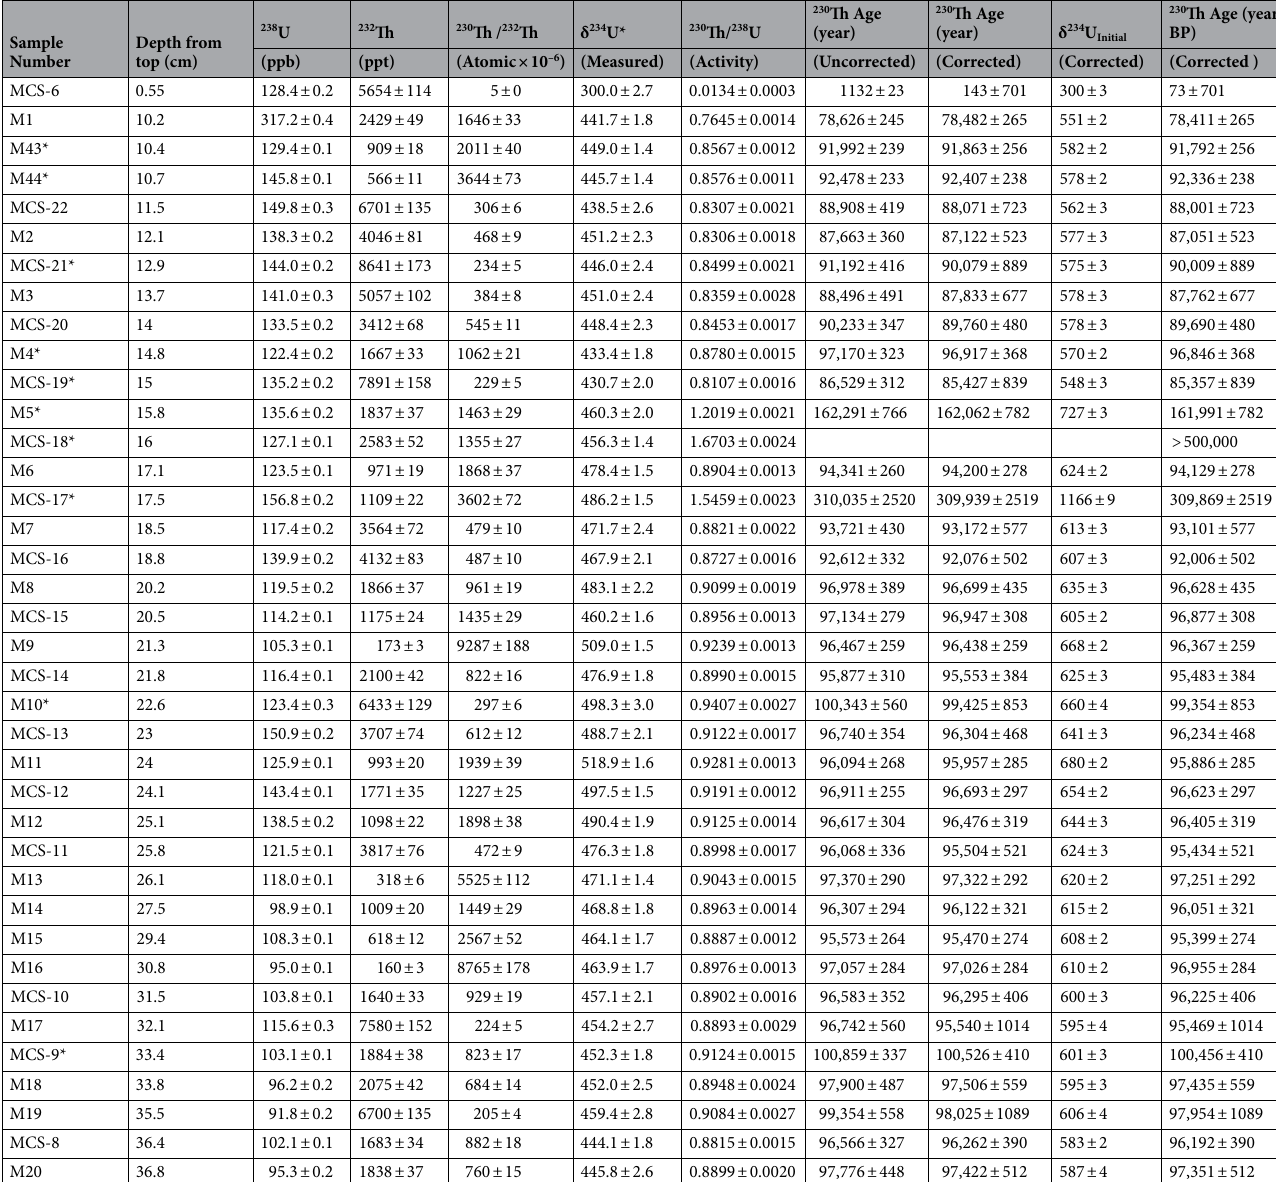
Table 2. U/Th dating results from the Isotope Laboratory of the University of Minnesota. *Refers to dating results that were not used in the age model. B.P. stands for “Before Present” where the “Present” is defined as the year 1950